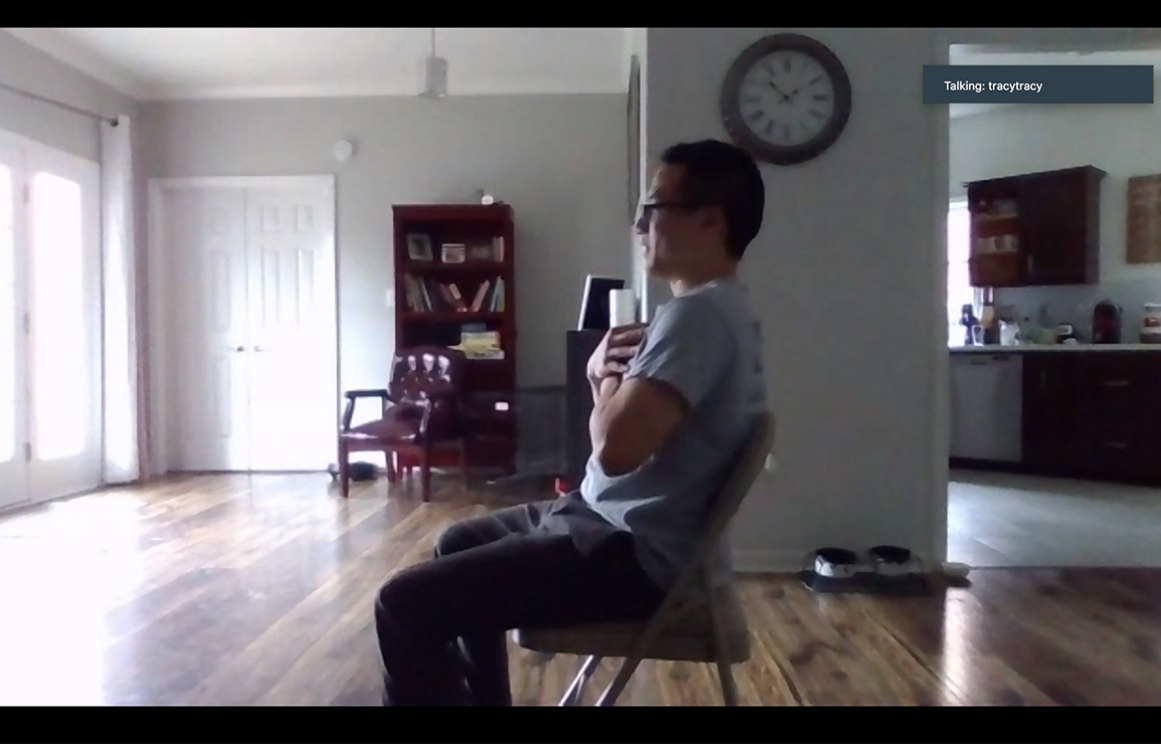
Figure 2. An example of the videoconference view of the starting position for the Five Times Sit to Stand test.